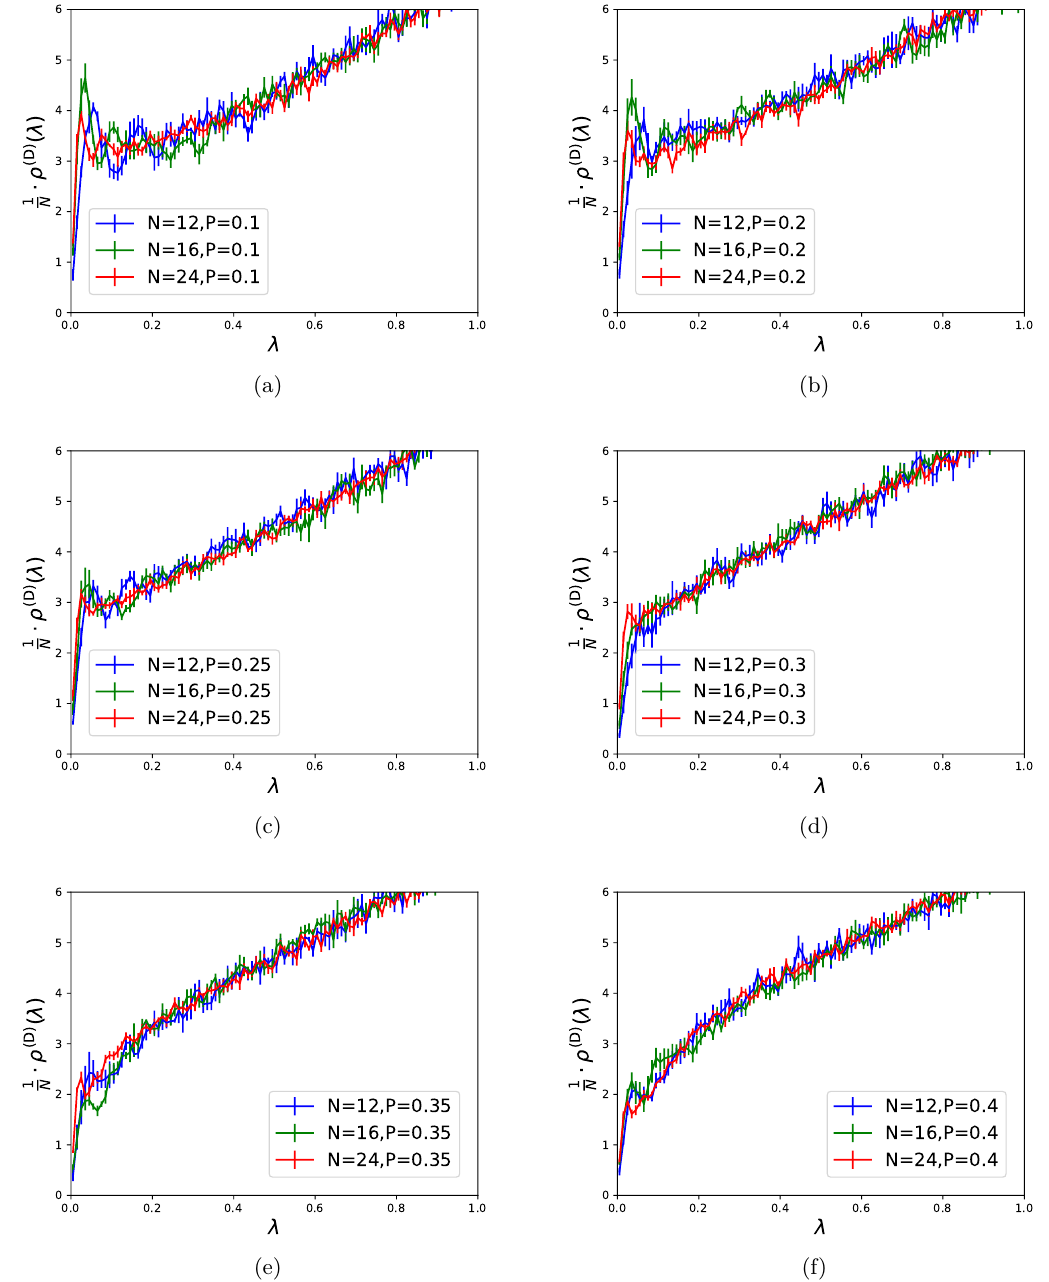
Figure 17. The density of Dirac eigenvalues, ρ (D) ( λ ) , divided by N , for N = 12 , 16 , and 24 , n t = 24 , and T = 0 . 29 , for various fixed values of P : (a)-(d) have P = 0 . 1 , 0 . 2 , 0 . 25 , 0 . 3 , respectively, which are all in the partial phase, while (e) and (f) have P = 0 . 35 and 0 . 4 , respectively, which are in the deconfined phase. In the partial phase, the behaviour is qualitatively similar to the confined phase in figure